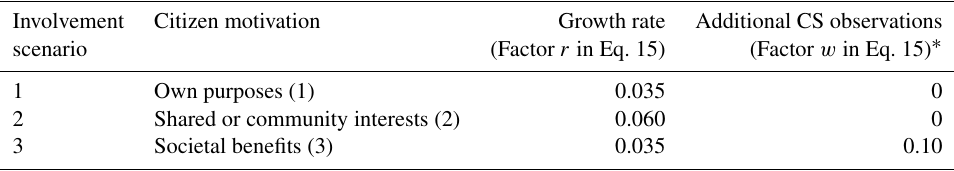
Table 6. Involvement curves based on different citizen motivations.